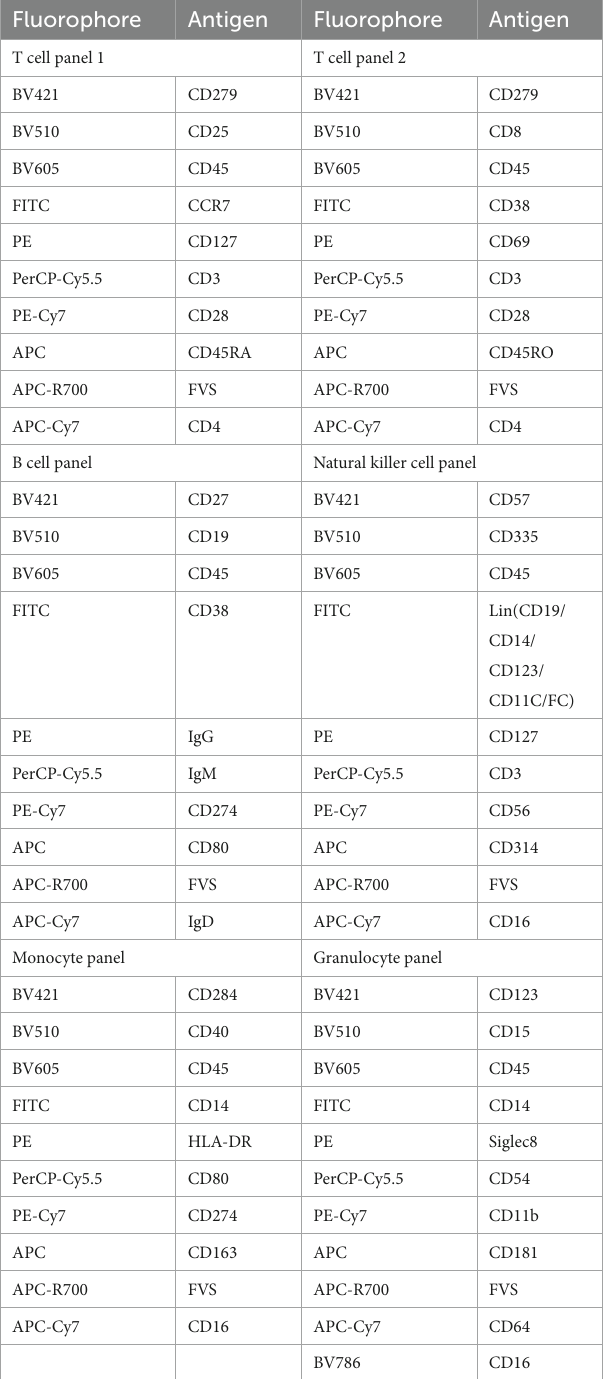
TABLE 3 Antibody panels to identify immune cell subsets by flow